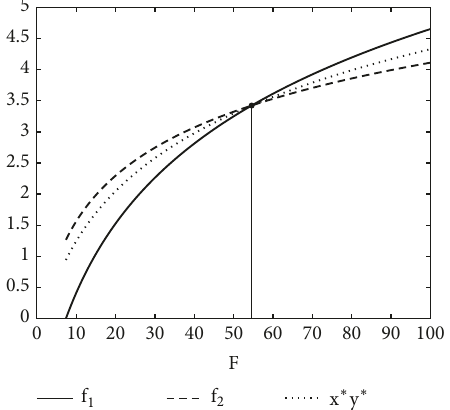
Figure 7: Graphs of 𝑓 1 , 𝑥 ∗ 𝑥 ∗ , and 𝑓 2 , 𝐹 < 100 . The 𝐹 region where (𝑥 ∗ ,𝑦 ∗ ) is stable is located to the left of the vertical line. 𝐺 = 4.623